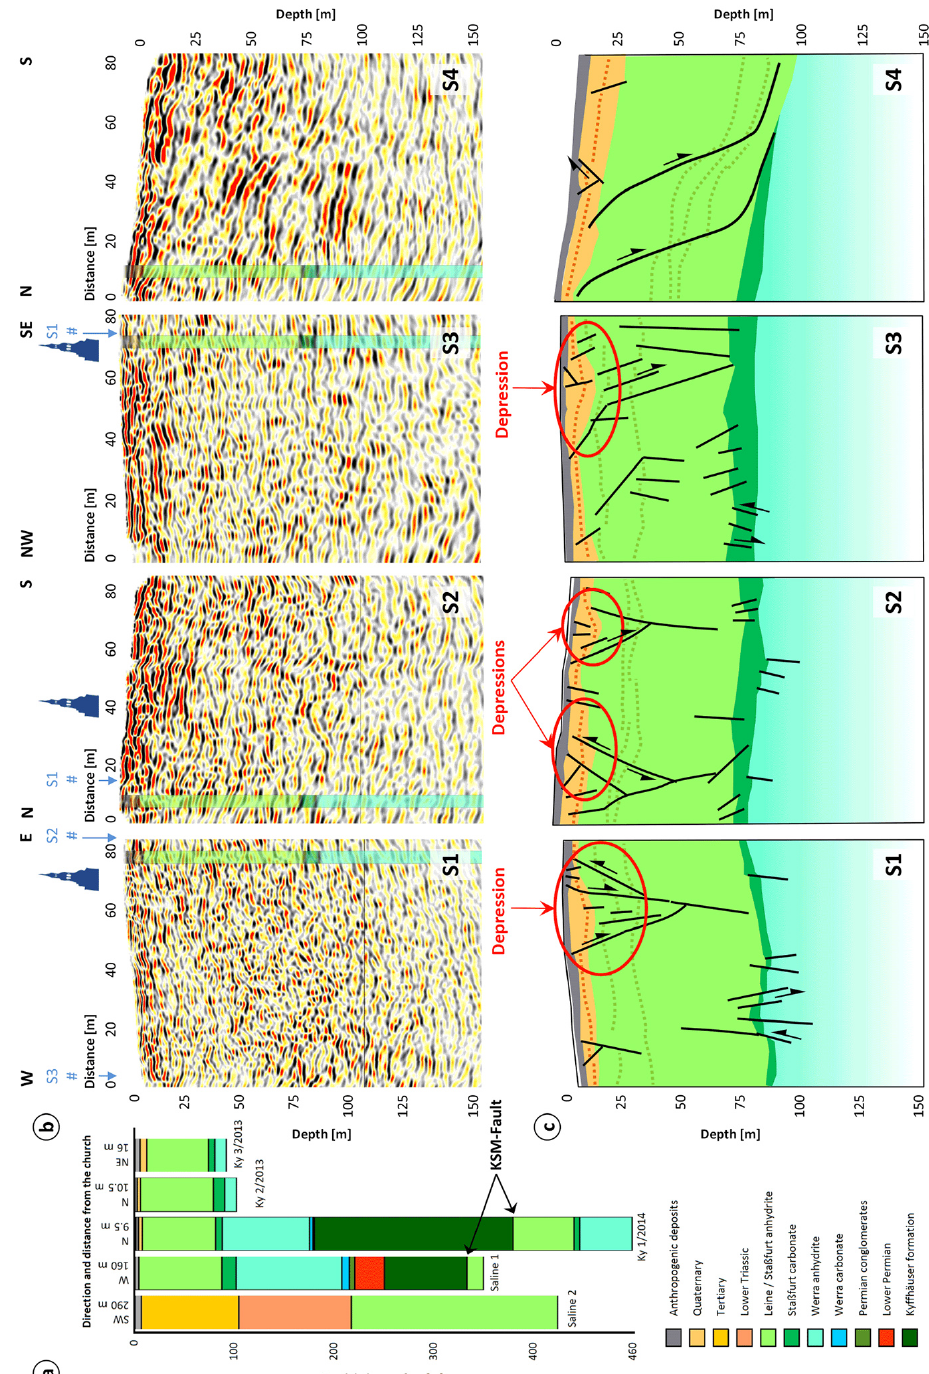
Figure 11. Five boreholes, located in the proximity of the church, give information about the lithologies (a) . Since the three boreholes located around the leaning church tower all show almost identical lithologies, only the lithologies of the research borehole Ky 1/2014 were used for correlation of the reflectors in the migrated and depth converted seismic sections S1–S4 (b) . The result are four interpreted sections (c) . The dashed lines show the internal stratification of the Quaternary and the Staßfurt anhydrite. The church tower is marked and the blue arrows on top mark intersection points of